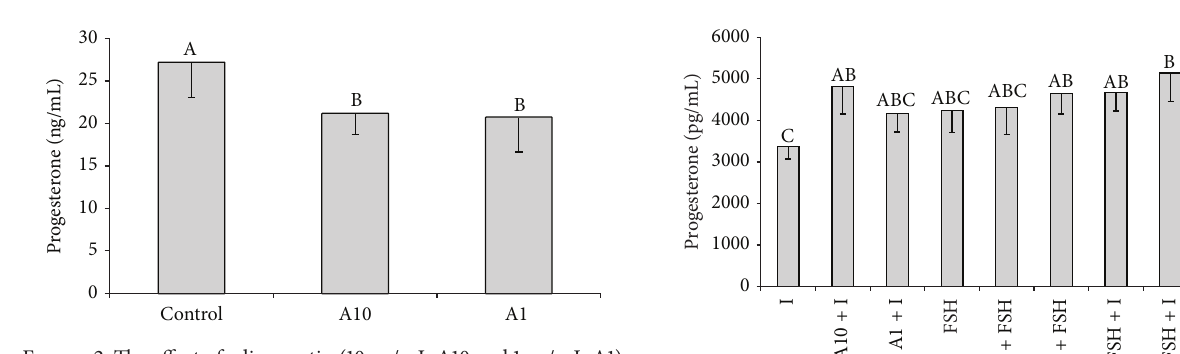
Figure 2: The effect of adiponectin (10 𝜇 g/mL-A10 and 1 𝜇 g/mL-A1) on basal progesterone secretion by cultured luteal cells collected on days 10–12 of the oestrous cycle. Bars with different superscripts are significantly different ( 𝑃 < 0.05 ). Result are means ± S.E.M. of five replicates.